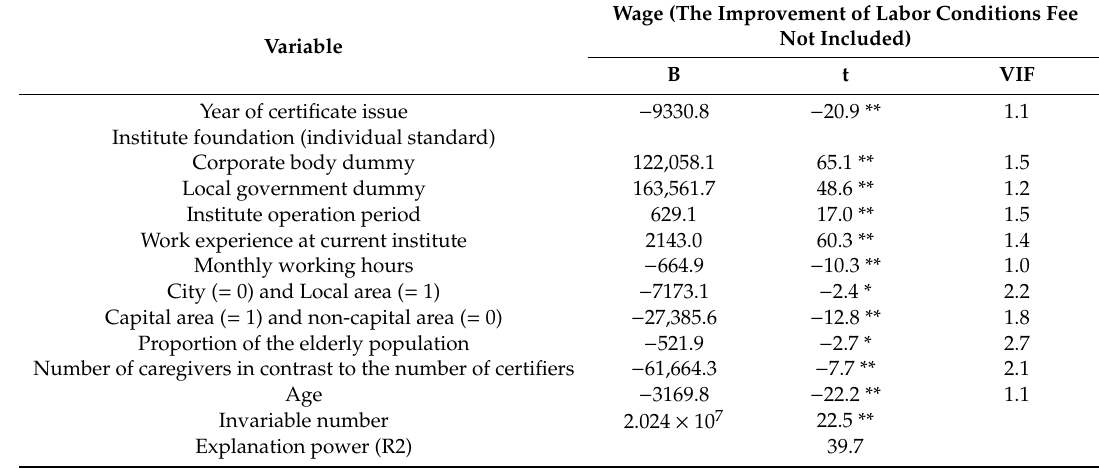
Table 6. Factors a ff ecting the wages of the care workers at residential care